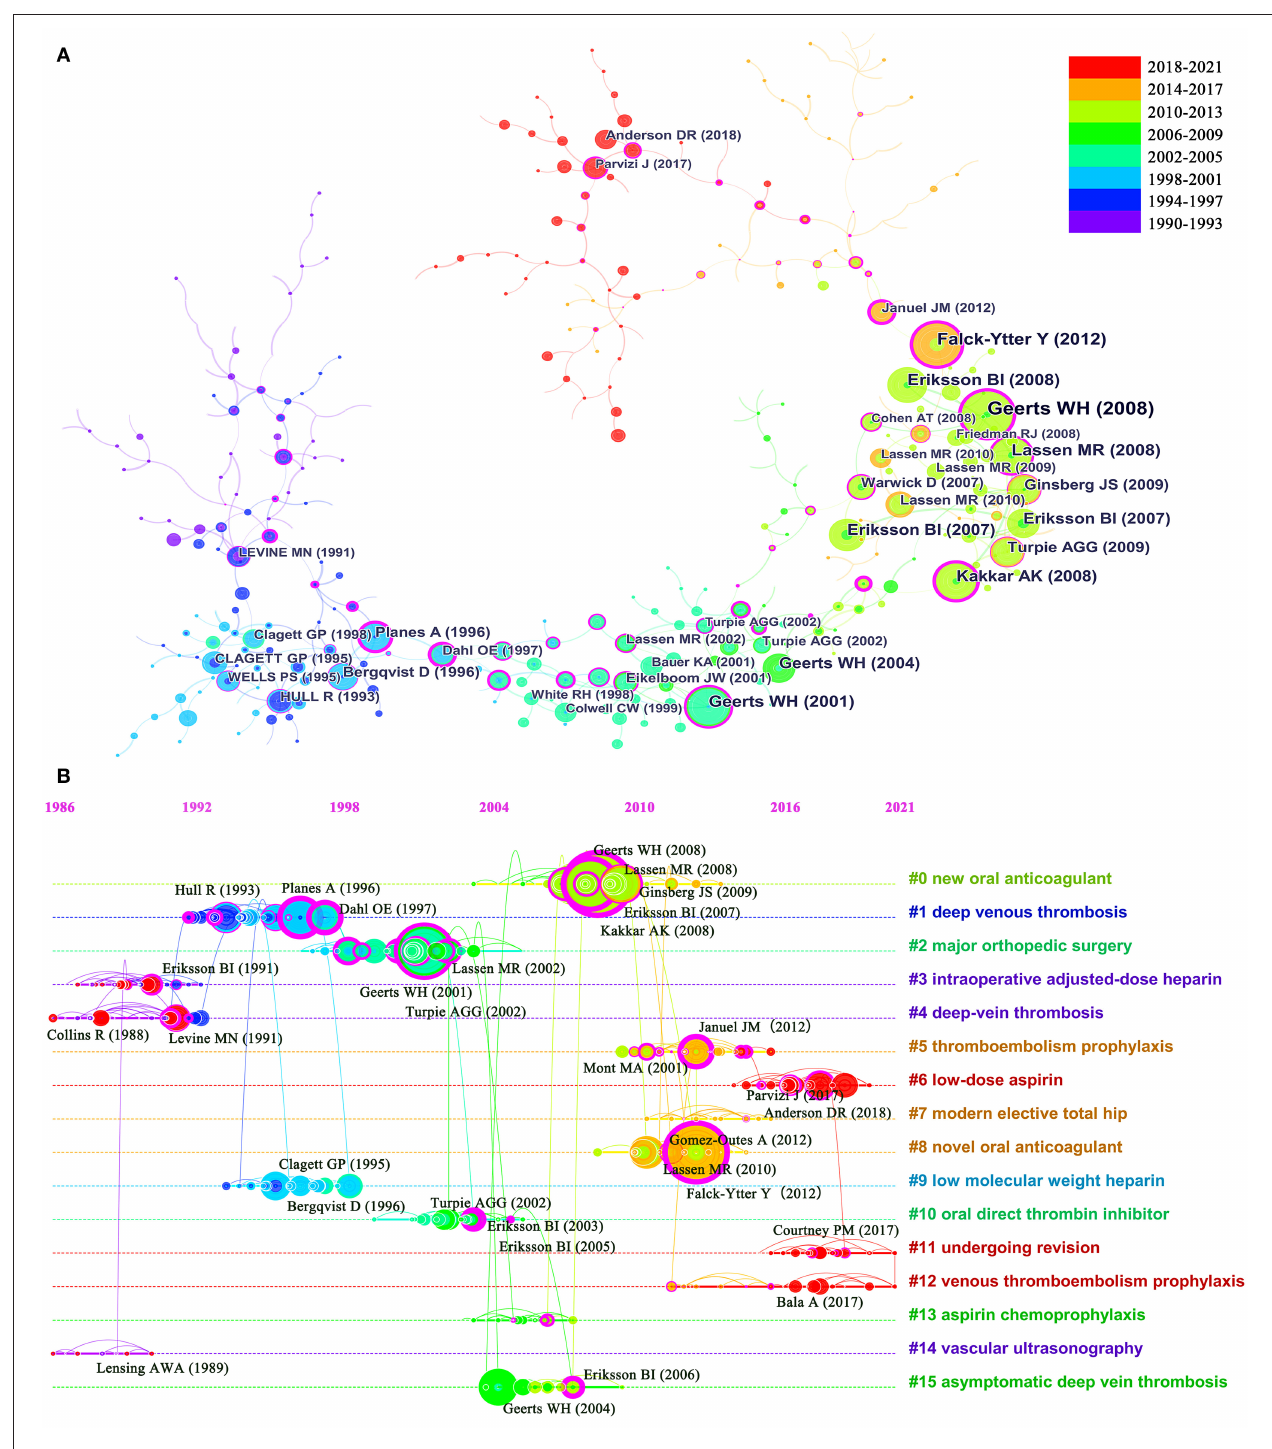
FIGURE 5 | The co-cited reference knowledge map (A) and the timeline graph of co-cited reference clustering (B)